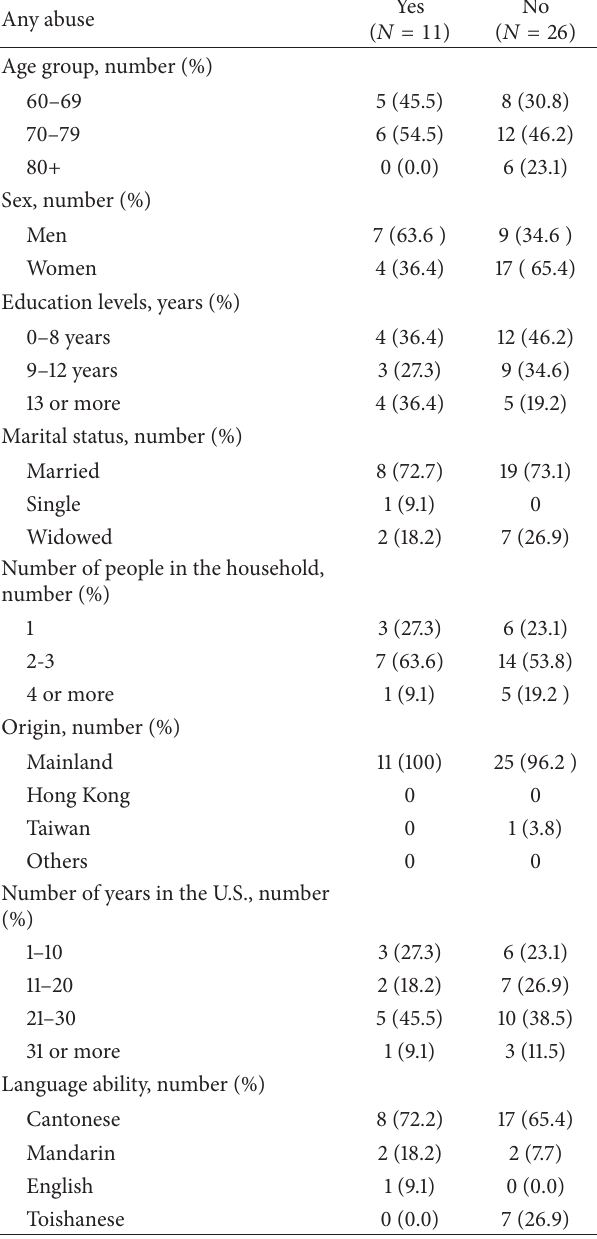
Table 1: Characteristics of the study population by the presence of elder